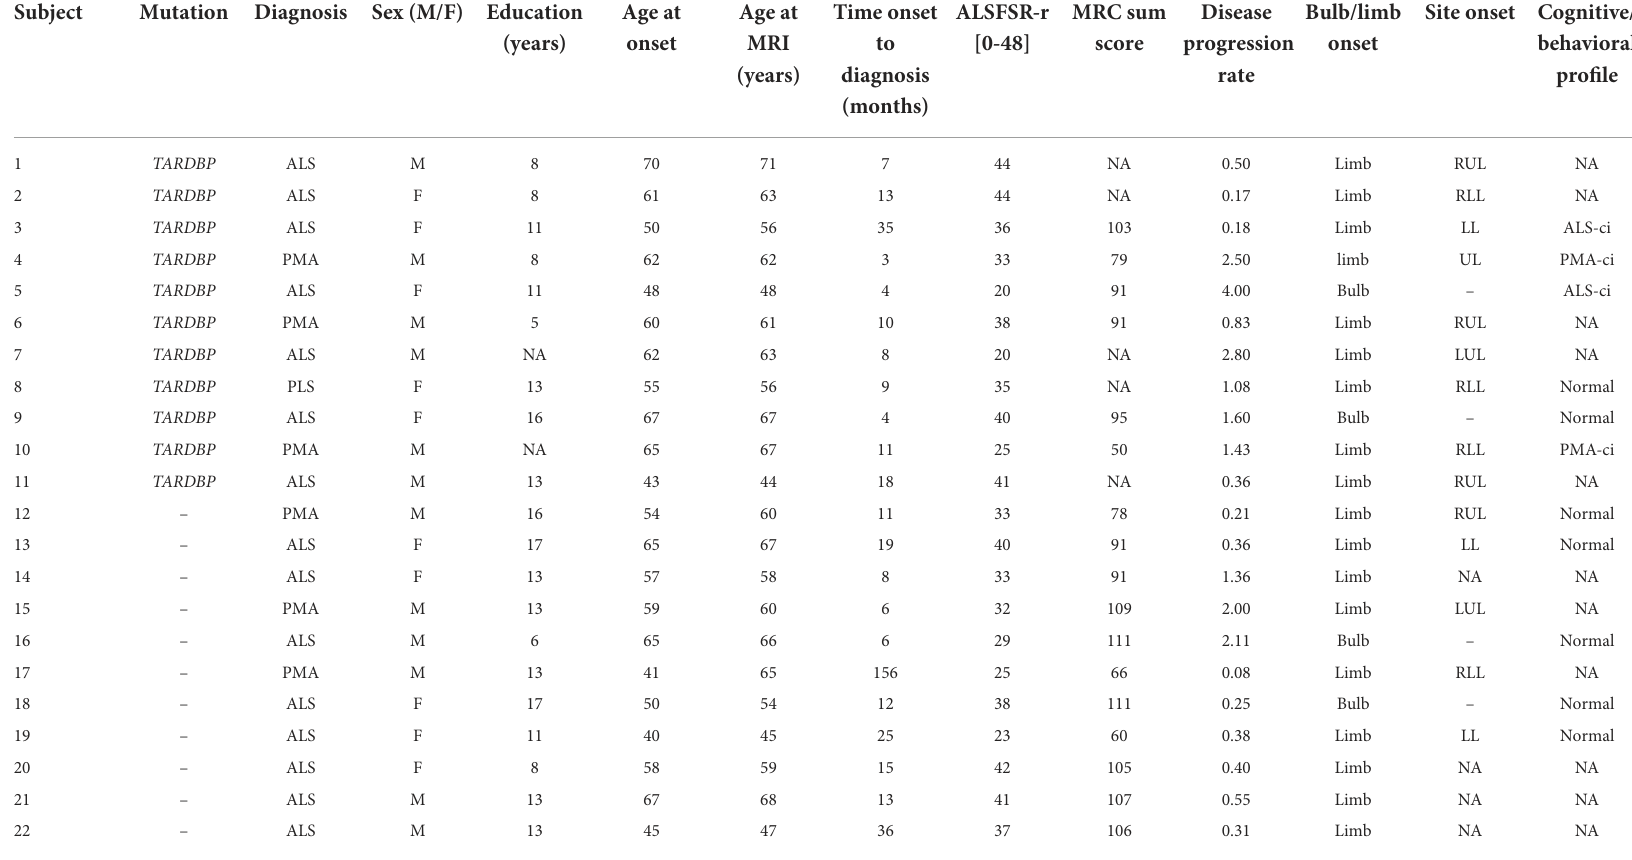
TABLE 2 Individual socio-demographic and clinical features of MND